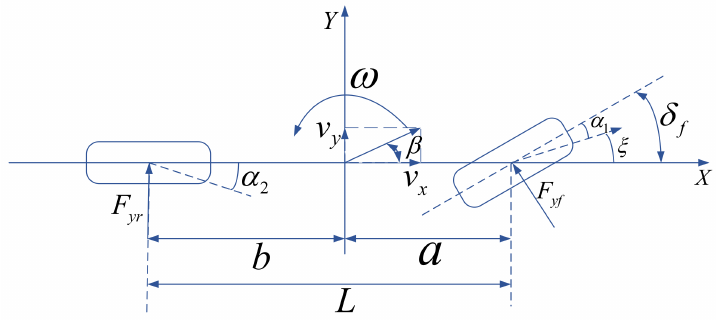
Figure 1. 2-DOF vehicle